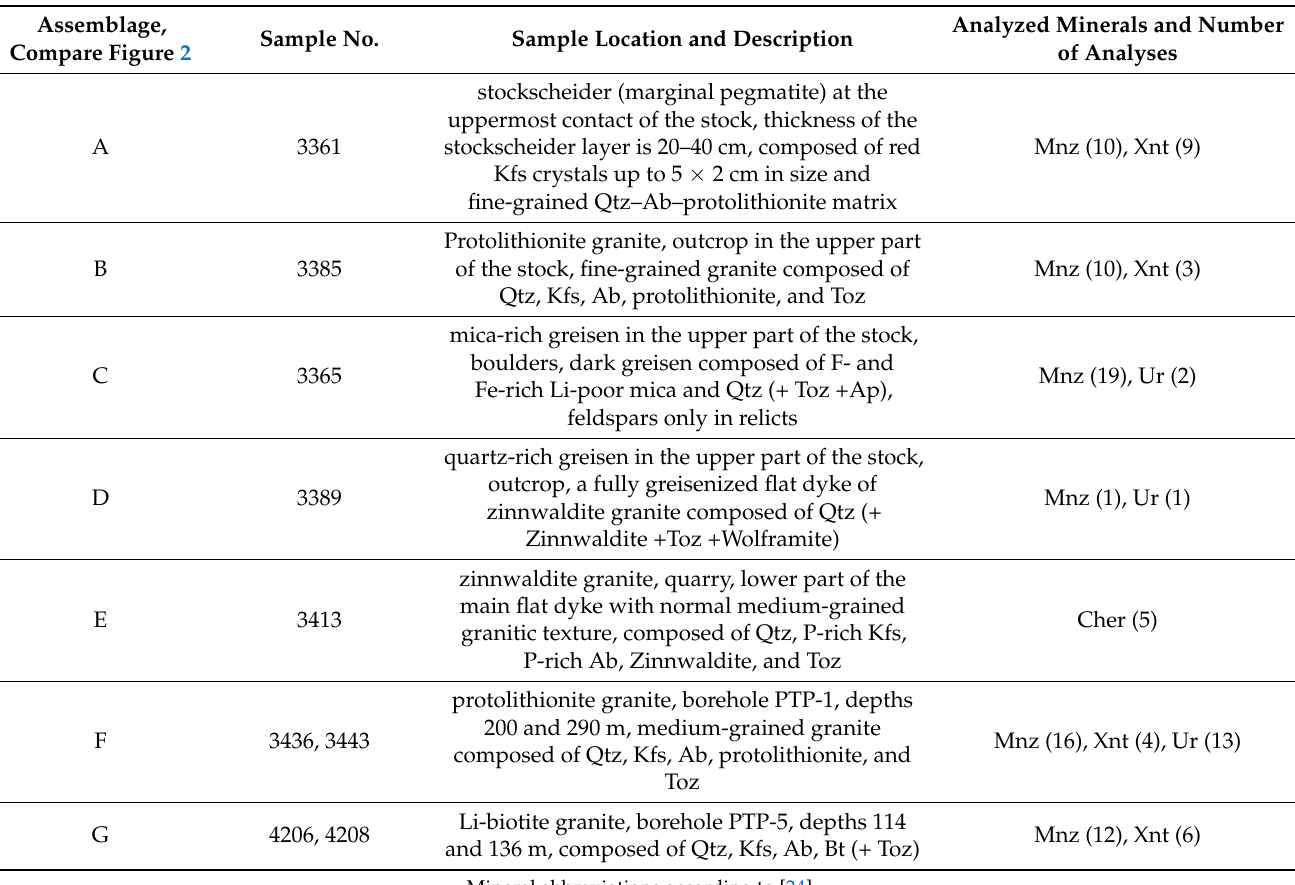
Table 1. The studied samples from Podles í .